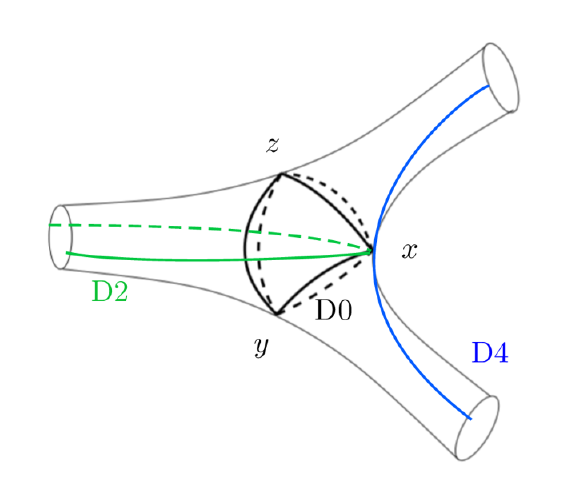
Figure 49. Rendering of the branes on the mirror curve for C 3 .